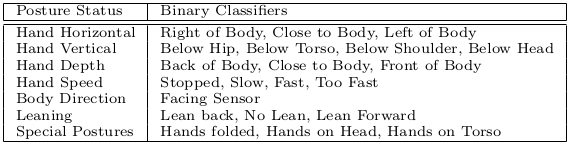
Table from the paper: Vision-based Engagement Detection in Virtual Reality
Table text:
Posture Status
Binary Classiﬁers
Hand Horizontal
Right of Body, Close to Body, Left of Body
Hand Vertical
Below Hip, Below Torso, Below Shoulder, Below Head
Hand Depth
Back of Body, Close to Body, Front of Body
Hand Speed
Stopped, Slow, Fast, Too Fast
Body Direction
Facing Sensor
Leaning
Lean back, No Lean, Lean Forward
Special Postures
Hands folded, Hands on Head, Hands on Torso